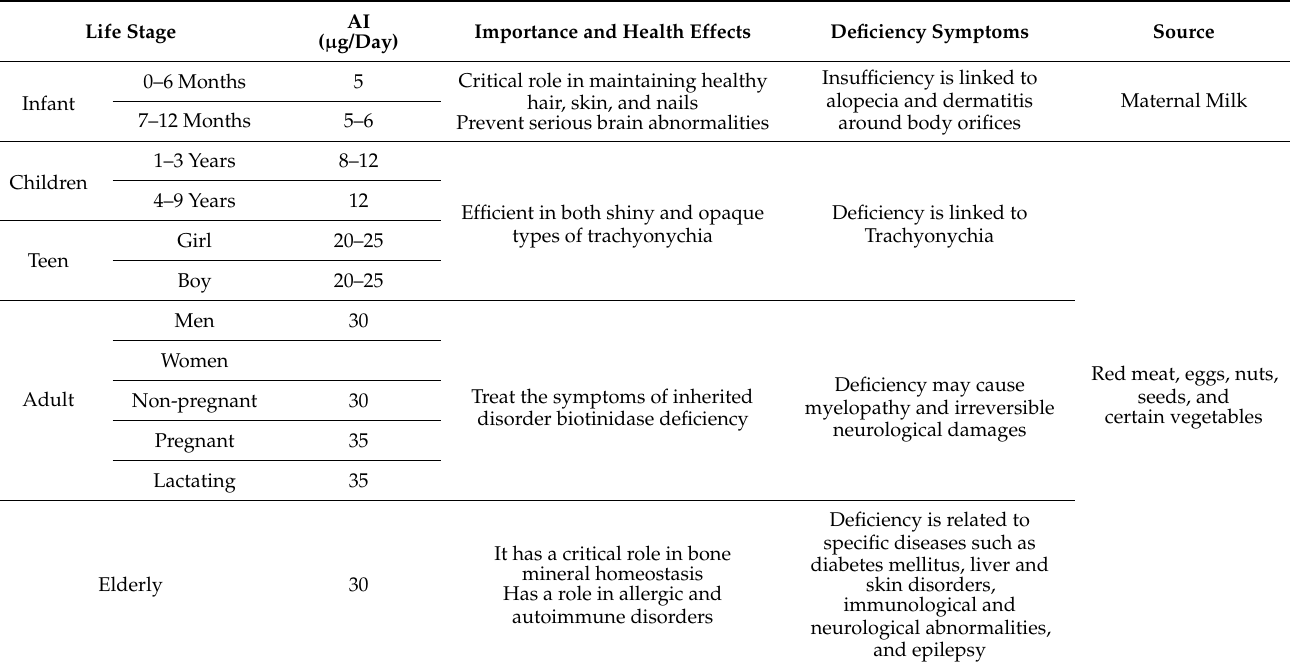
Table 6. Adequate daily intake (AI), main actions, and natural sources of vitamin B7 (Biotin) in different life